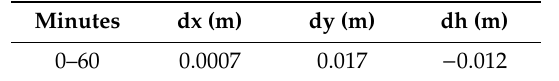
Table 5. 60 min session positioning results summary, baseline OPNT–P30Pro (4 km).